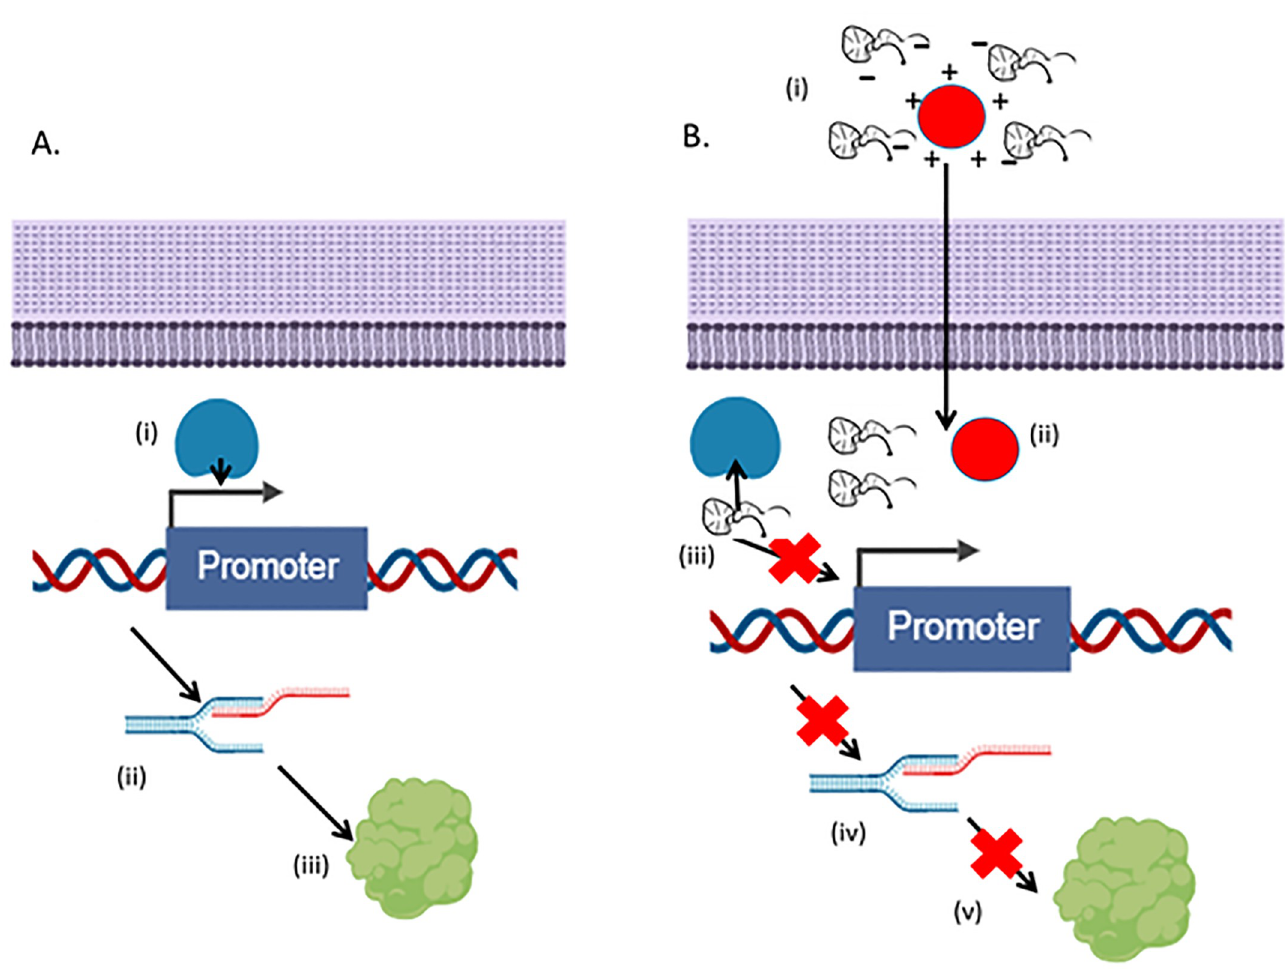
Fig 1. Schematic of nanoparticle-mediated TFD delivery and inhibition of S . aureus replication. A) Normal transcription process whereby (i) the transcription factor protein (s) bind their relevant promoter region which results in (ii) transcription and mRNA production which is then (iii) translated to functional protein. B) (i) Following administration of TFD-nanoparticles, (ii) these traverse the bacterial cell wall and membrane and TFD is decomplexed (iii) TFDs competitively inhibit the transcription factor binding to DNA promotor region in the bacterial chromosome and therefore (iv) considerably reduce or even inhibit transcription and (v) translation of crucial cell wall proteins (image made in